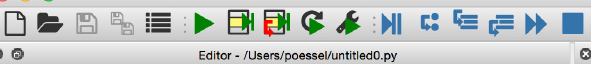
Fig. 80.— Part of the top bar of Spyder at the icons. The first from the left is the “New File” icon, which produces a new Python script window for you to write code in. The second from the left is “Open File” which opens an existing file. Third from the left is the “Save” icon — as everyone will tell you, save your file frequently, please! We will ignore the other icons for now and return to the green play